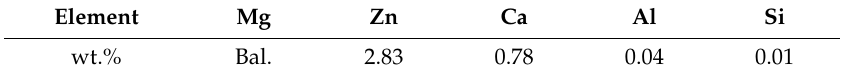
Table 1. Composition of the Mg-Zn-Ca alloy (wt.%).